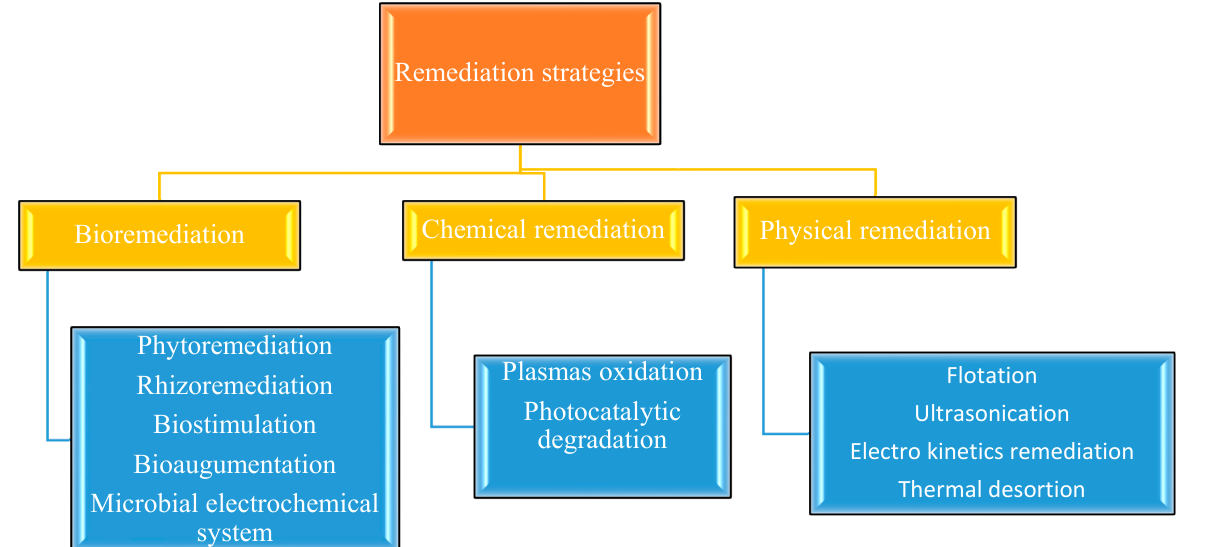
Figure 5. Diagram of soil remediation techniques for oil-contaminated areas.